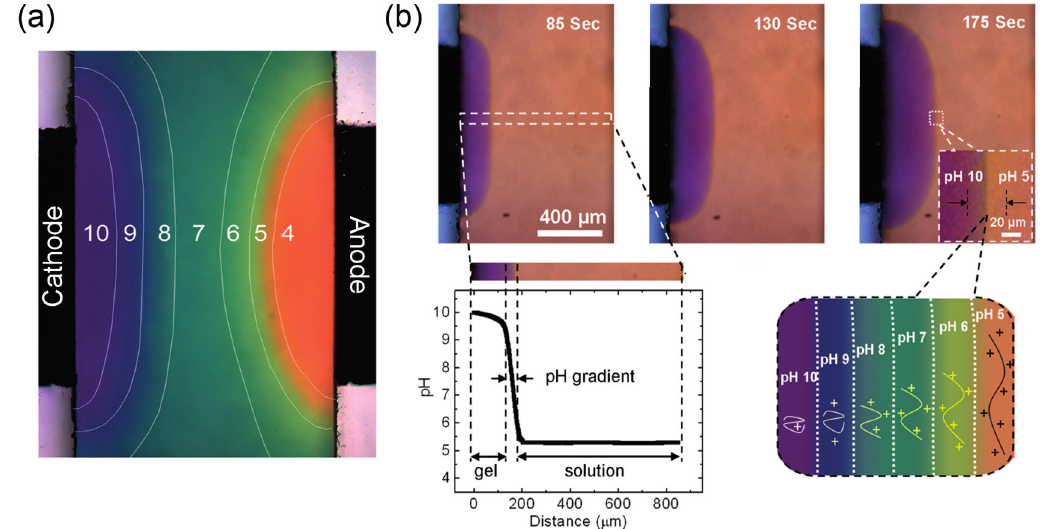
Figure 6. Measurements of the electrode induced pH gradient indicate that chitosan electrodeposition occurs as a moving front of both pH and gelation. Electrochemical pH gradient ( a ) in the absence of chitosan and ( b ) in the presence of chitosan. Reproduced with permission from [77], published by Royal Society of Chemistry,